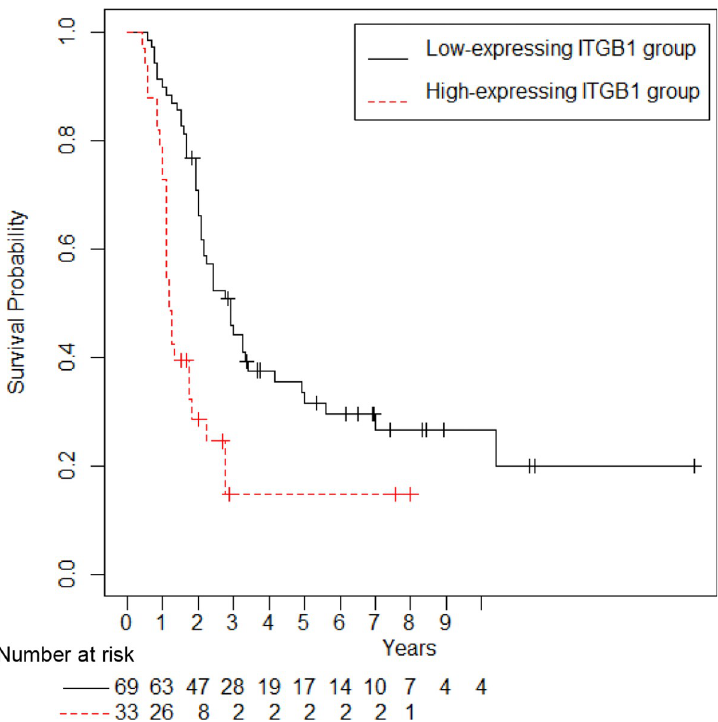
Fig 2. Correlation between high expression of ITGB1 and poor outcomes in PDAC patients. Kaplan-Meier analysis of postoperative survival according to ITGB1 expression is shown.